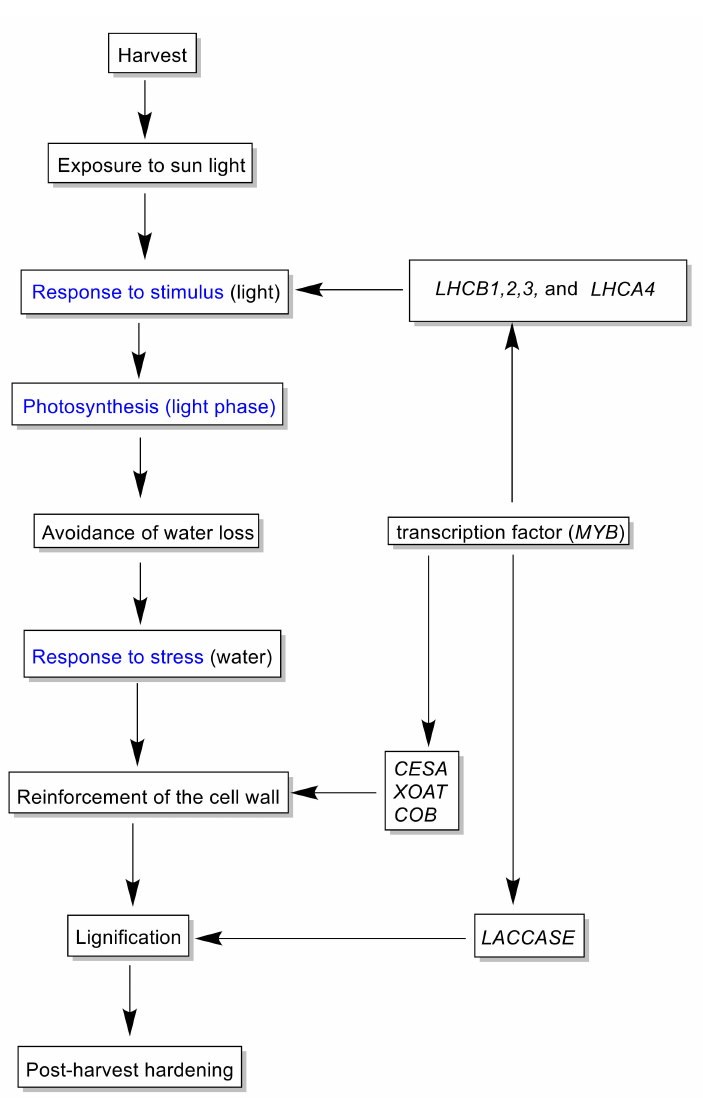
Figure 9. Putative mechanism of the PHH in D. dumetorum . Blue represents GO